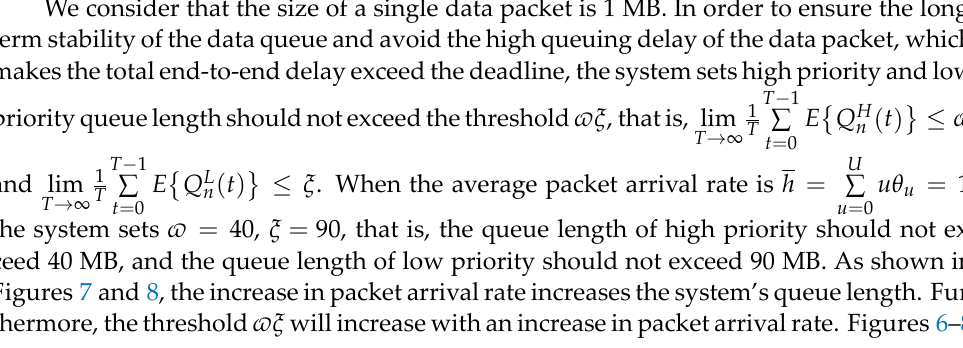
Figure 7. Comparison of high-priority queue lengths under different packet arrival rates. Figure 8. Comparison diagram of low-priority queue lengths under different packet arrival rates. We consider that the size of a single data packet is 1 MB. In order to ensure the long- term stability of the data queue and avoid the high queuing delay of the data packet, which makes the total end-to-end delay exceed the deadline, the system sets high priority